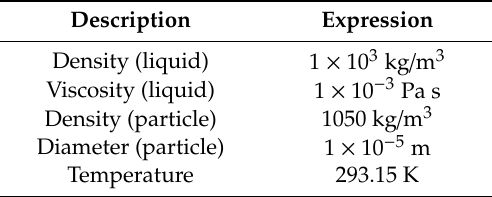
Table 2. Constants of the liquid and sample particles used in the theoretical simulation.